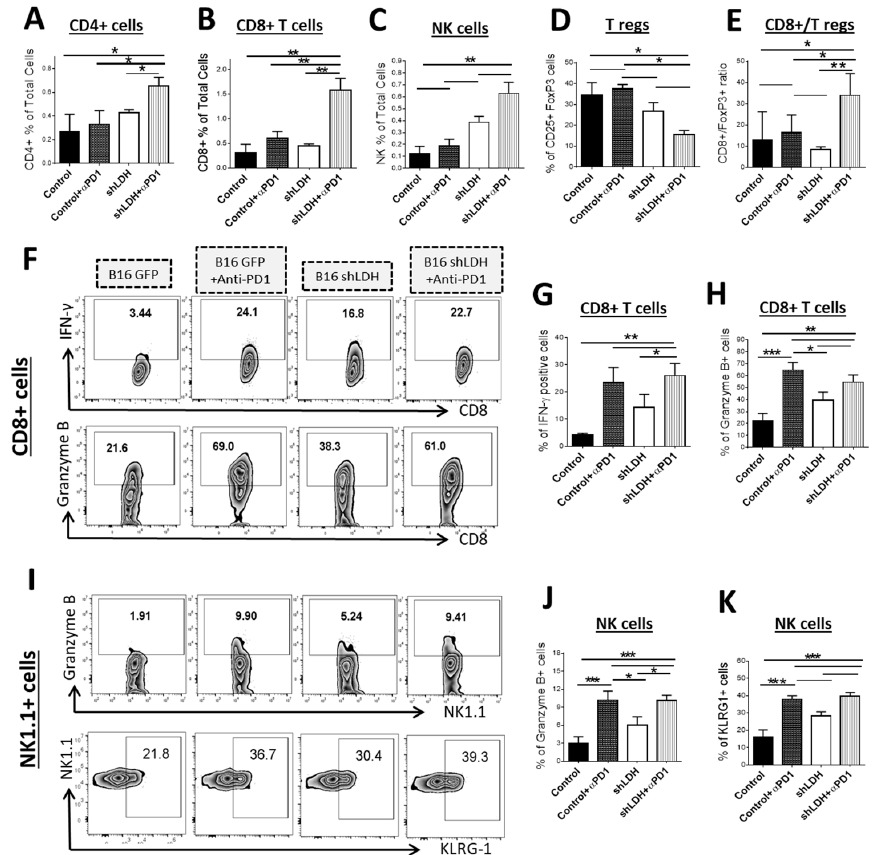
Figure 2. Immunophenotype of intra-tumoral immune cells. ( A–D ) Intra-tumoral infiltration of CD4 + T-cells ( A ), CD8 + T cells ( B ), natural killer (NK) cells ( C ), T regulatory (Treg) cells ( D ) and CD8 + /Treg ratio ( E ) were evaluated by flow cytometry. The combination of anti-PD-1 use with the deletion of